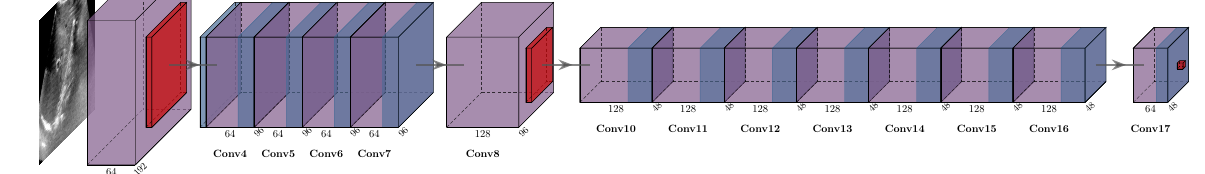
Figure 2. Visualisation of the modified ResNet-18 backbone for an example input image of 160 × 190, with reduced number of blocks, and, importantly, fewer downsampling steps to preserve spatial resolution of features. Residual connections were present in the model but not